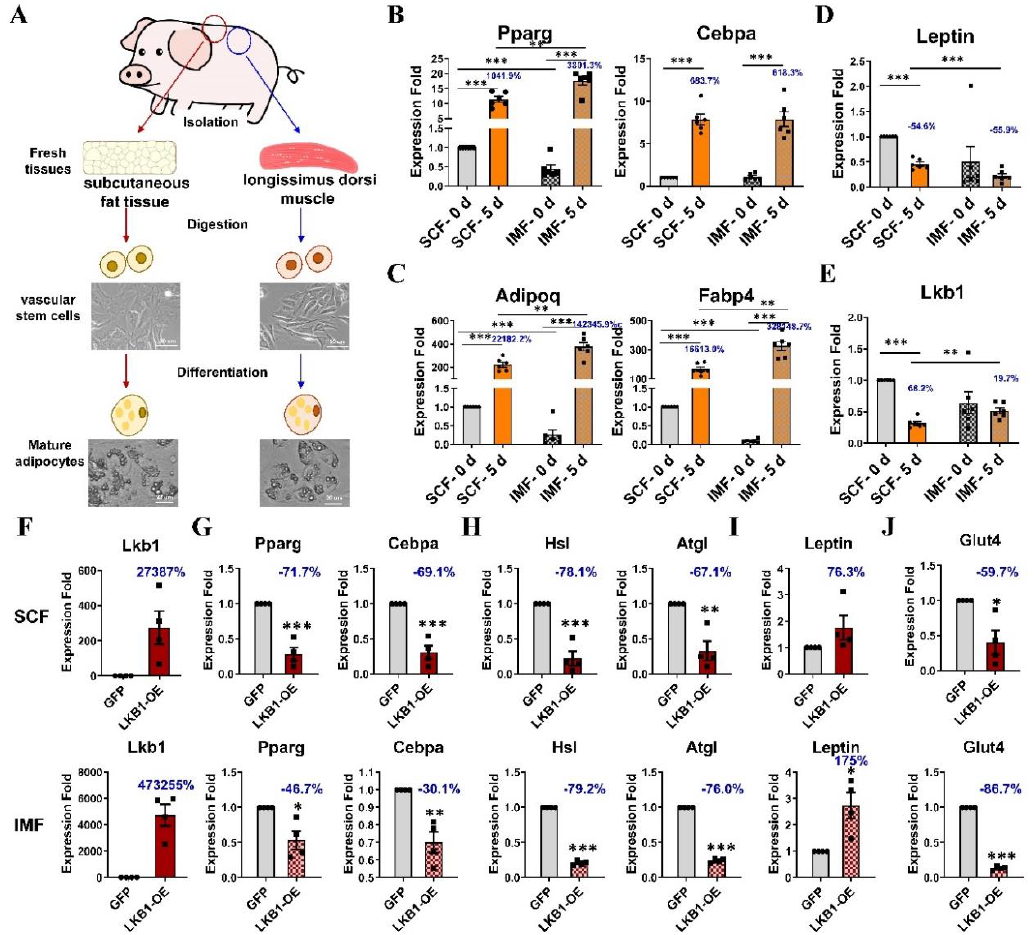
Figure 1. Comparison of pig intramuscular fat (IMF) and subcutaneous fat (SCF) adipocytes exposed to adipogenic differentiation medium and overexpressing liver kinase B1 (LKB1). ( A ) Experimental design. IMF and SCF preadipocytes were isolated from muscle and adipose tissues, respectively, from three 3-day-old pigs and used in subsequent experiments (n = 6). ( B – E ) q-PCR results of the mRNA levels of Pparg , Cebpa ( B ), Adipoq , Fabp4 ( C ), Leptin ( D ), and Lkb1 ( E ) in SCF and IMF adipocytes